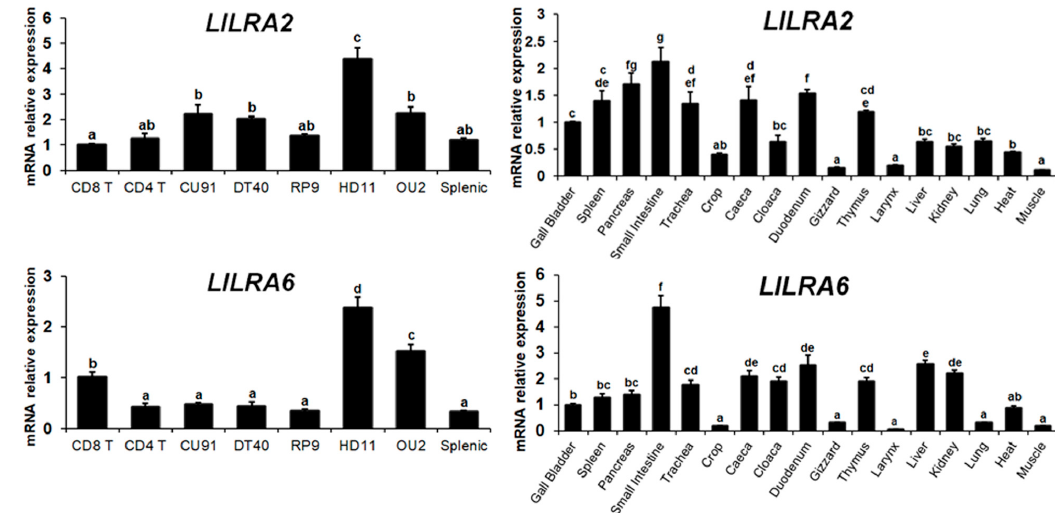
Figure 2. Expression of chicken LILRA2 and LILRA6 mRNA in chicken tissues and cells. ( Left ) The expression of LILRA2 and LILRA6 mRNA in chicken cells; ( Right ) Expression of LILRA2 and LILRA6 mRNA in normal tissues. Gene expression levels were normalized to GAPDH and calibrated with CD8 T-cell and gall bladder expression in chicken cell and tissues, respectively. Data are presented as the mean ± SEM of three independent experiments and values with different superscript characters (a, b, c, d, e, f and g) indicate significant differences between the control and treatment groups as determined by one-way ANOVA ( p < 0.05).